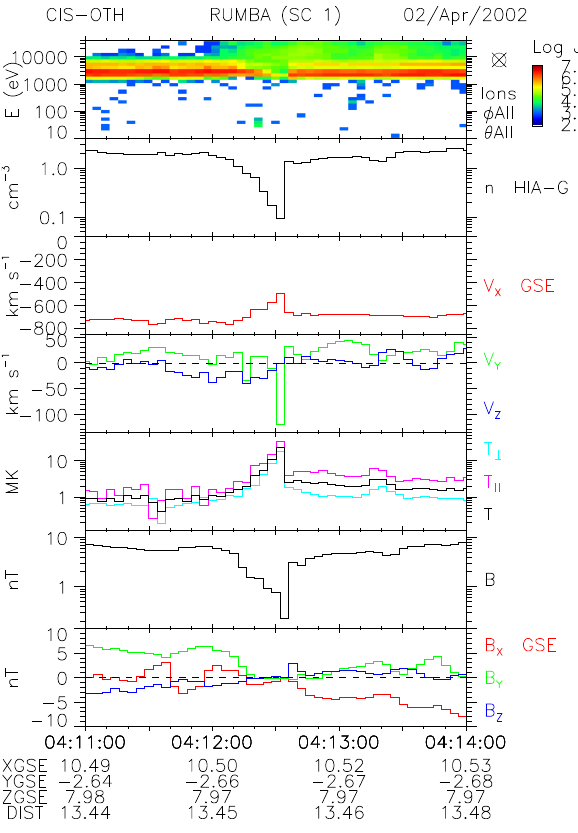
Fig.2. Fig. 2. 2 April 2002 04:11–04:14UT summary plot. Same format as for Fig. 1.